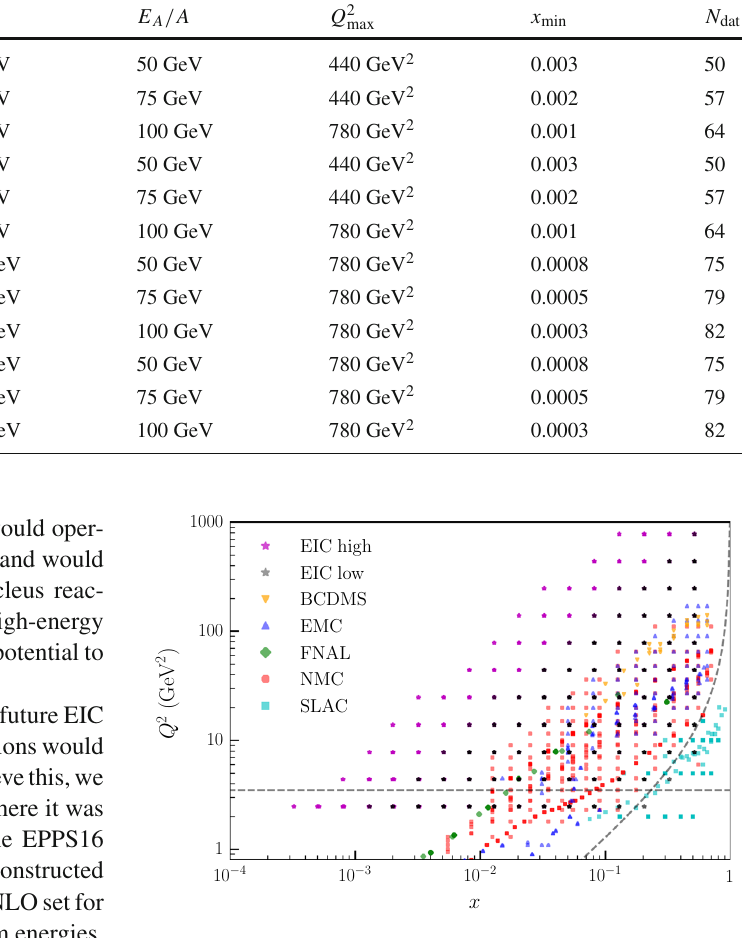
Table 6 The different scenarios for the EIC pseudo-data considered here. For each scenario, we indicate the atomic mass number A , the electron energy E e , the nucleus (per nucleon) energy E A / A , the maxi- mum value of Q 2 and the minimum value of x reached, and the number